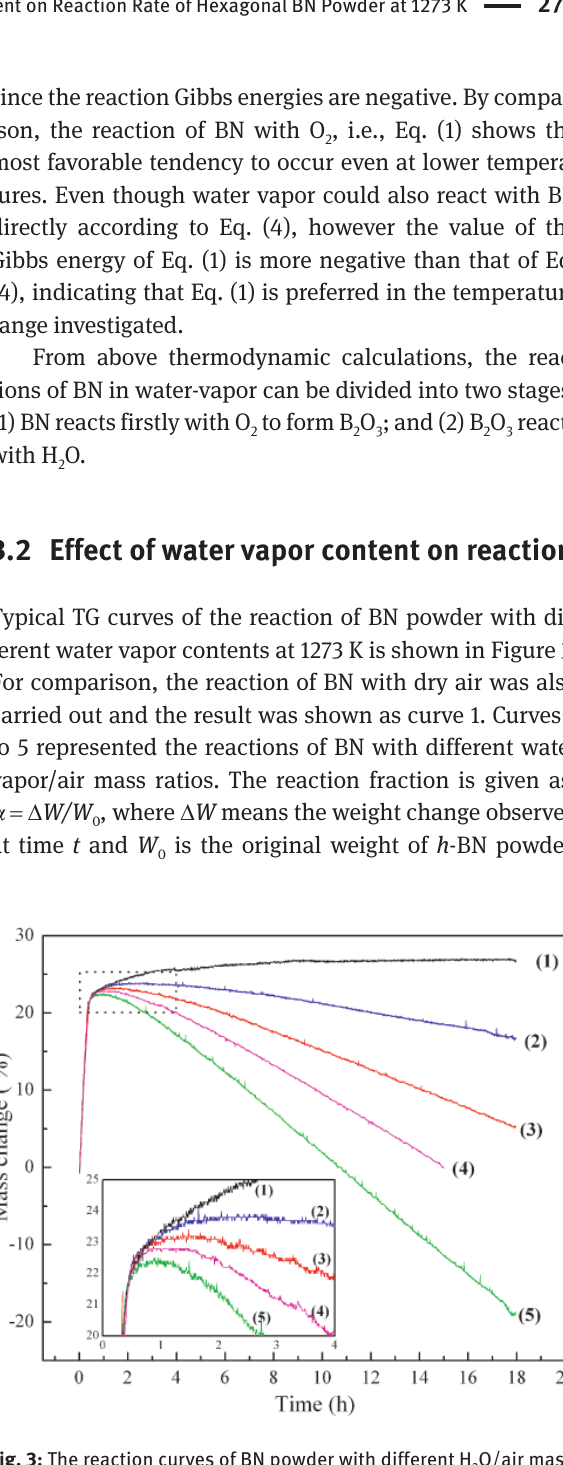
Fig. 2: The standard reaction Gibbs energy of the possible reactions of BN in combustion environments